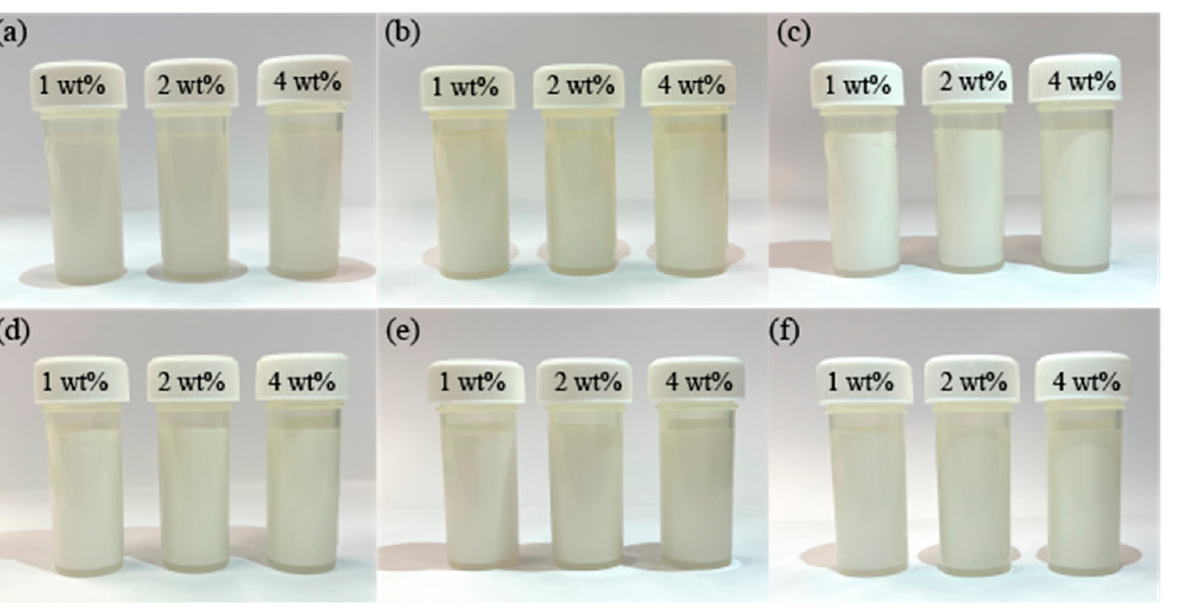
Figure 6. Sedimentation of TiO 2 NPs dispersed in different glycerol-based nanolubricants at a settling time of ( a ) 0 h; ( b ) 24 h; ( c ) 48 h; ( d ) 72 h; ( e ) 96 h; and ( f ) 120 h.